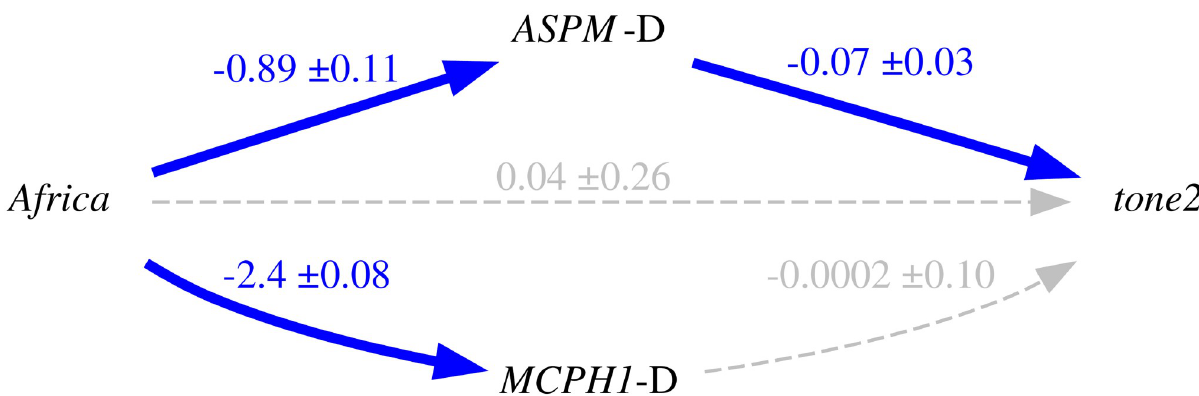
Fig 23. Summary of the 1,000 path models for tone2 fitted to restricted samples. Same conventions as in Fig 14.